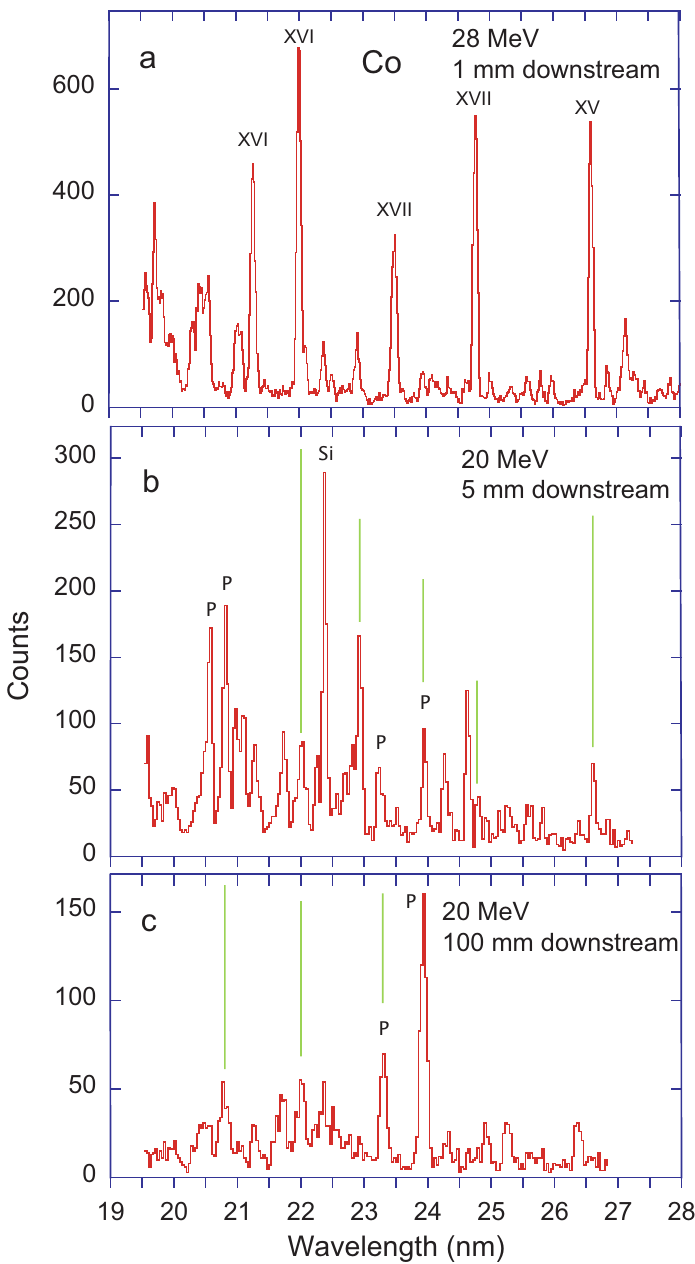
Figure 26. Beam-foil spectra of Co at relative high ion beam energies. Observation ( a ) at a position 1mm from the foil (delay 100ps), ion beam energy 28MeV, line width (FWHM) 0.075nm; ( b ) delay 600ps, ion beam energy 20MeV, line width (FWHM) 0.075nm; ( c ) delay 12ns, ion beam energy 20MeV, line width (FWHM) 0.12nm. The strongest lines in the top spectrum are identified by the spectrum number. Several lines are marked by their isoelectronic sequence. Vertical green lines indicate candidates for wavelength reference transfer